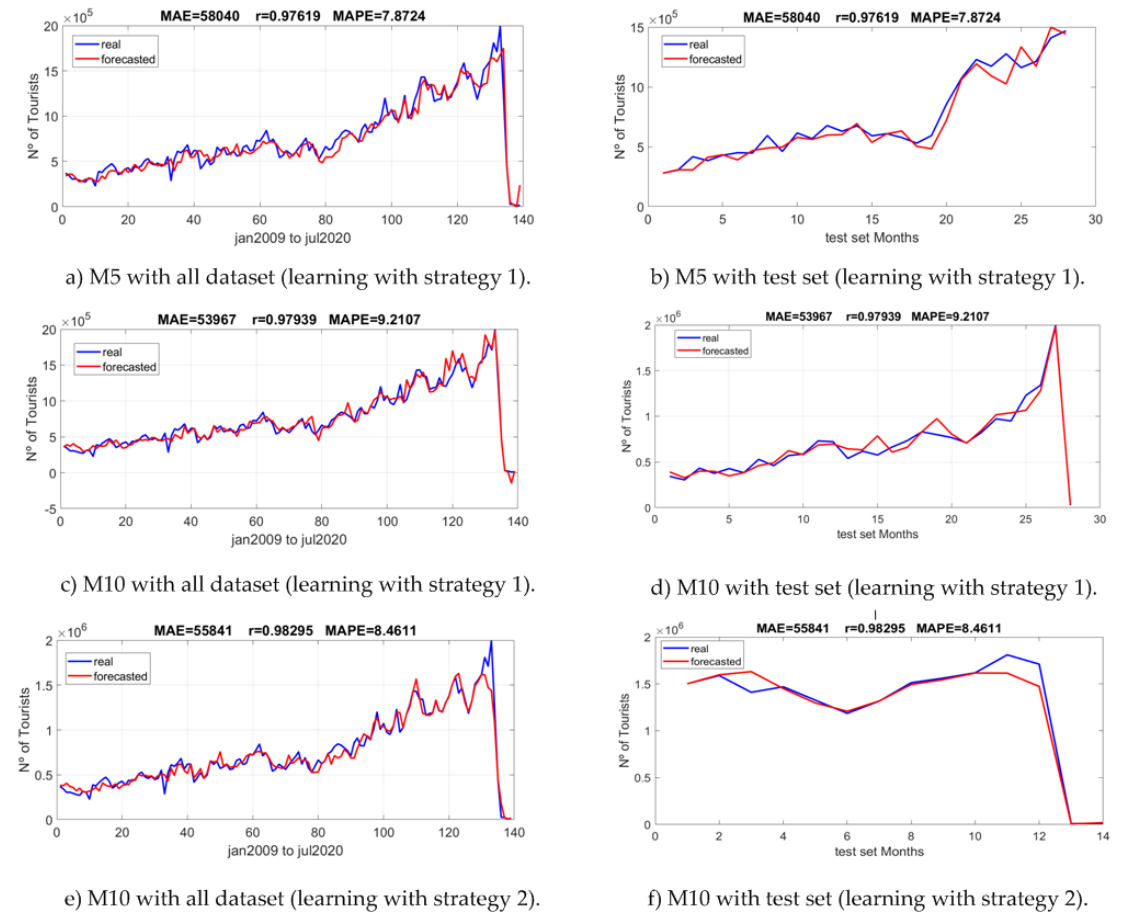
Figure 8. The real and predicted values of the monthly number of international tourists. Source: Authors’ elaboration.